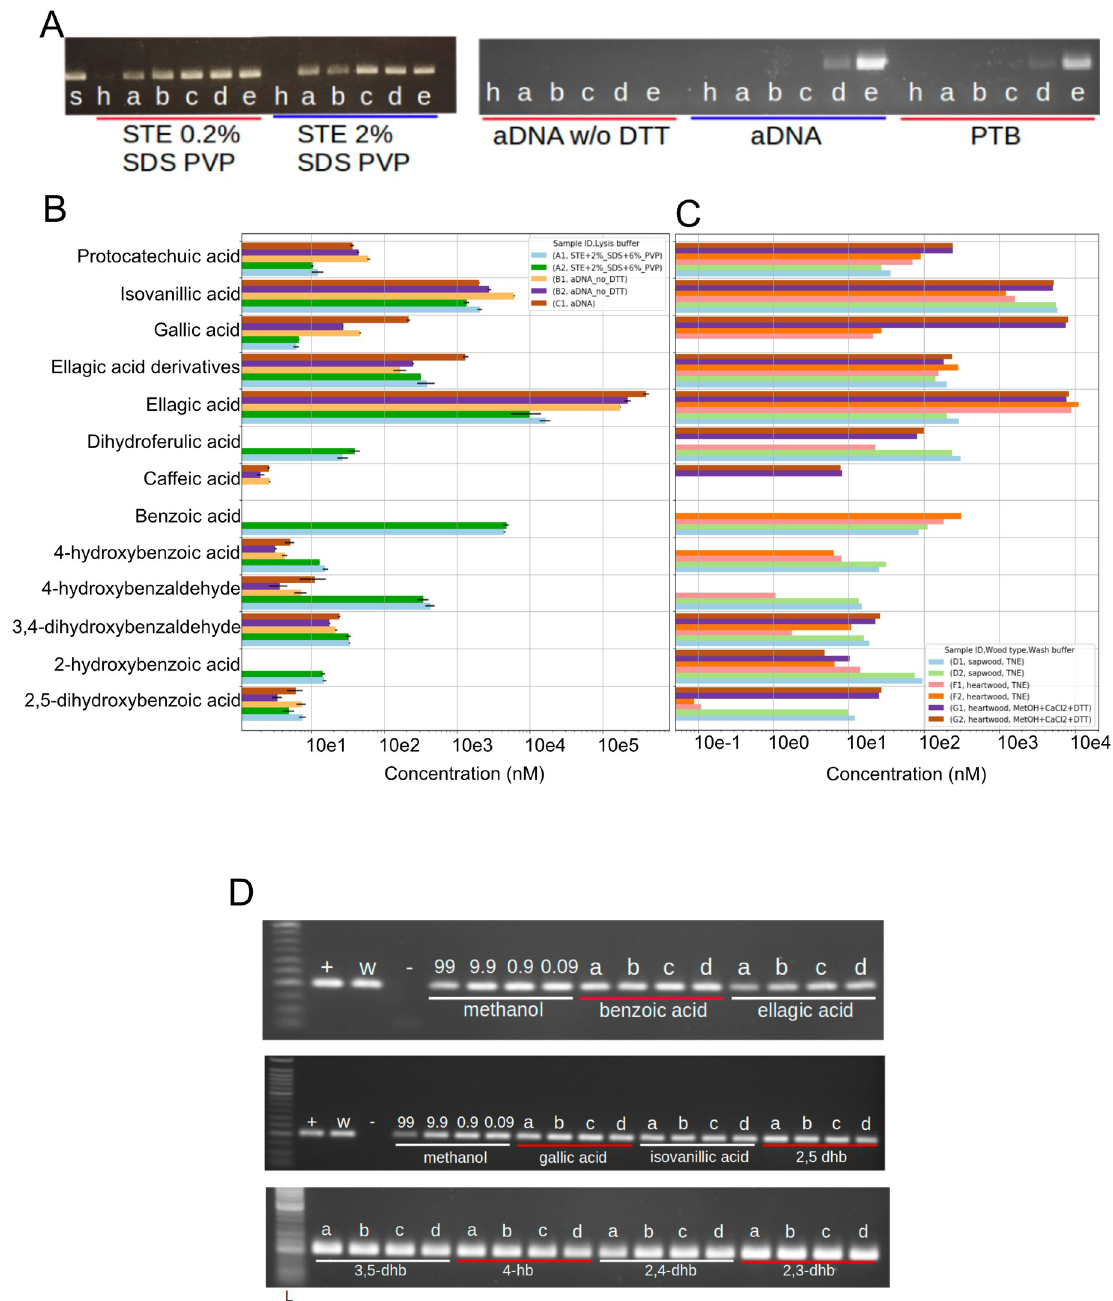
Fig 1. PCR-inhibitory effect of heartwood DNA extracts. A) PCR inhibitory effect of heartwood DNA extracts obtained with STE 2% SDS 6% PVP, STE 0.2% SDS 6% PVP, aDNA buffer with and without DTT, PTB buffer. Amplifiable sapwood DNA extract (s) was titrated with heartwood DNA extract (h) at 1:4 (a), 2:4 (b), 3:4 (c), 3.25:4 (d), 3.5:4 (e). Sapwood-heartwood extract DNA was amplified by PCR for 40 cycles. The two panels of this figure were taken from different gels under the same experimental conditions. B, C) Concentration of phenolic compounds and ellagic acid derivatives in DNA extracts obtained from oak heartwood (B) and from the washing surnatants of oak sapwood and heartwood (C). Error bars represent the standard deviation. D) Concentration of the tested compound: a) 1.0 mM, b) 0.1 mM, c) 0.01 mM, d) 0.001 mM. Sapwood (+), 50% diluted sapwood (w), PCR negative control (-). Hb: hydroxybenzoic acid, dhb: dihydroxybenzoic acid. Ellagic acid is dissolved in methanol which is why controls with the addition of only methanol to the PCR were carried out (99%, 9.9%, 0.9%, 0.09%). The upper, middle, and lower panels of this figure were taken from different gels under the same experimental conditions.